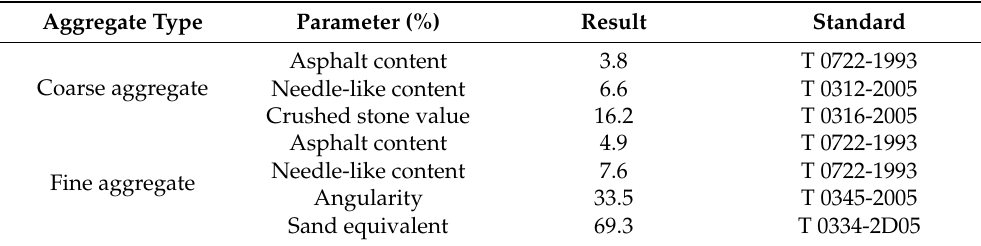
Table 2. Aggregate properties of the studied RAP.